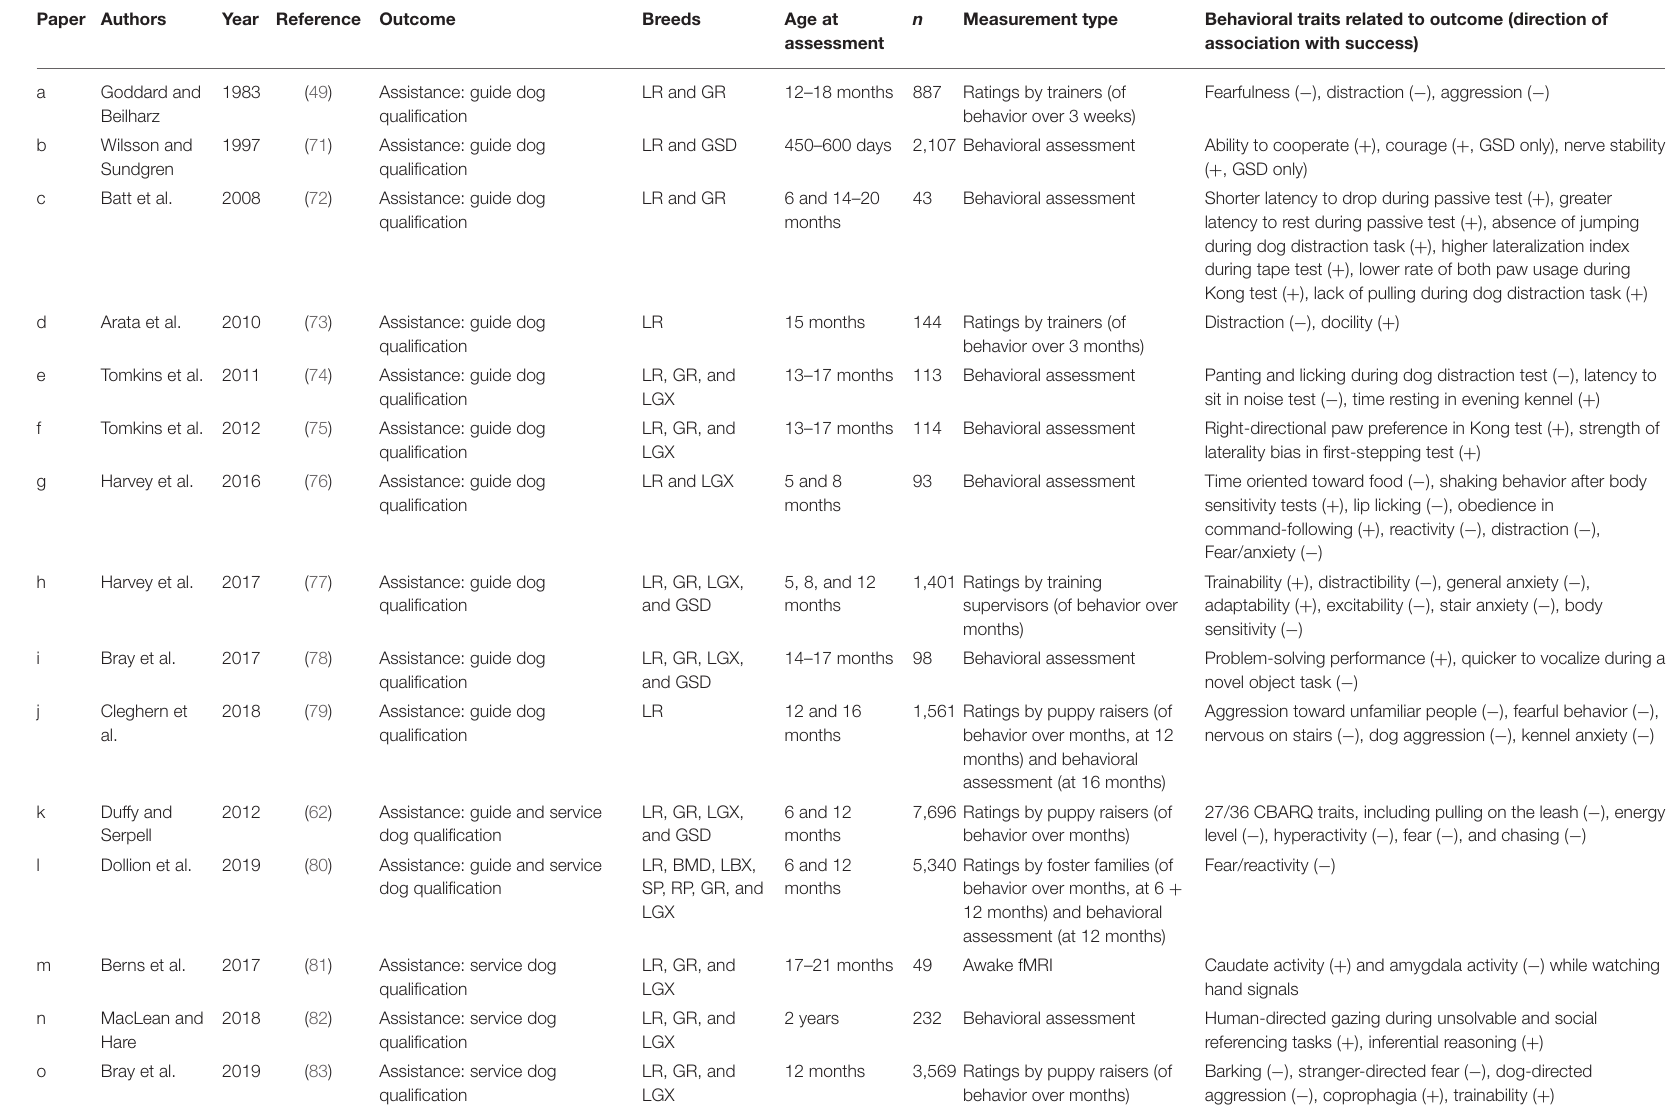
TABLE 1 | Associations between behavior and outcomes in adolescent and adult candidate working dogs. Paper